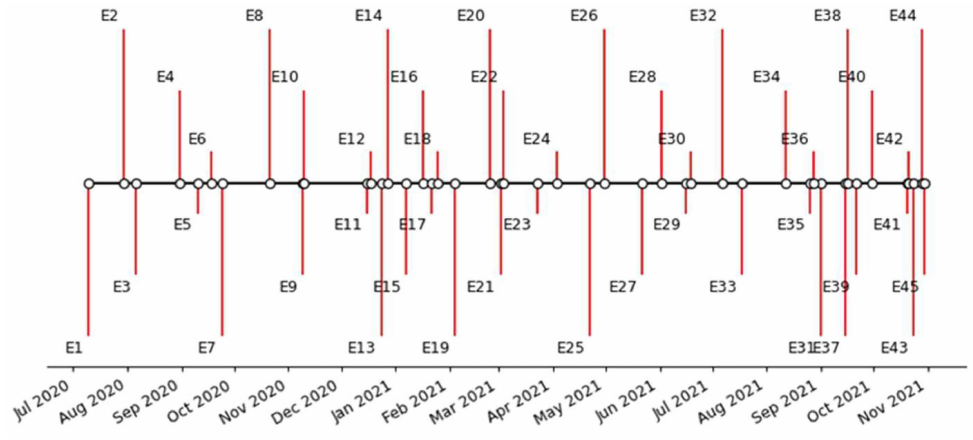
Figure 11. Events